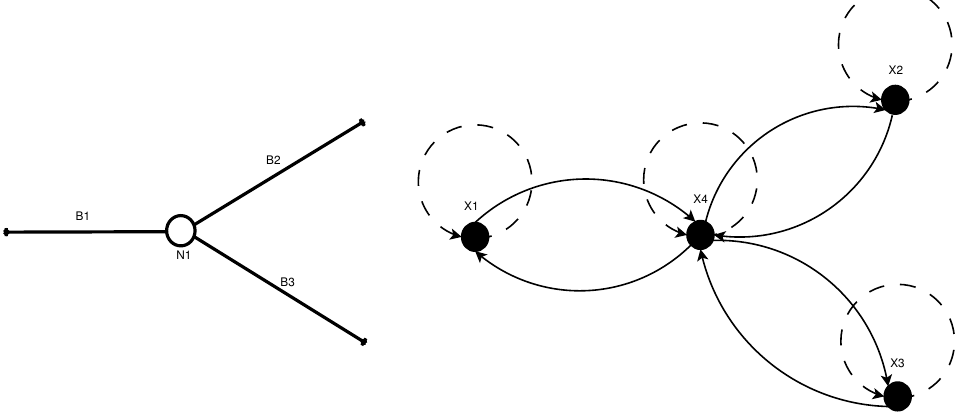
Figure 4. Relation between the mine scheme ( left ) and the directed graph G ( A Λ ) ( right